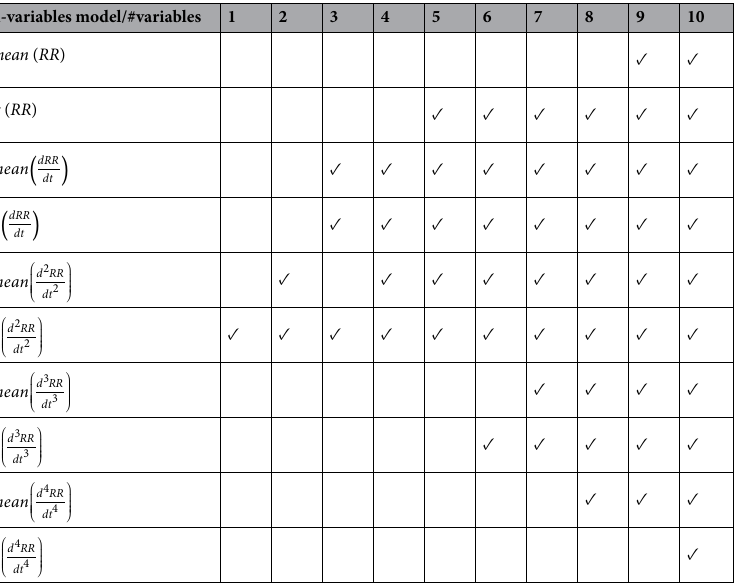
Table 2. Variables selected through γ -analysis. For a given number n (1–10) of selected variables used in a classifier model, the table shows the combinations of variables that yield the highest γ -values when the mean and standard deviation operators are applied to the RR interval time series (N = 7,400) and their four first time derivatives.